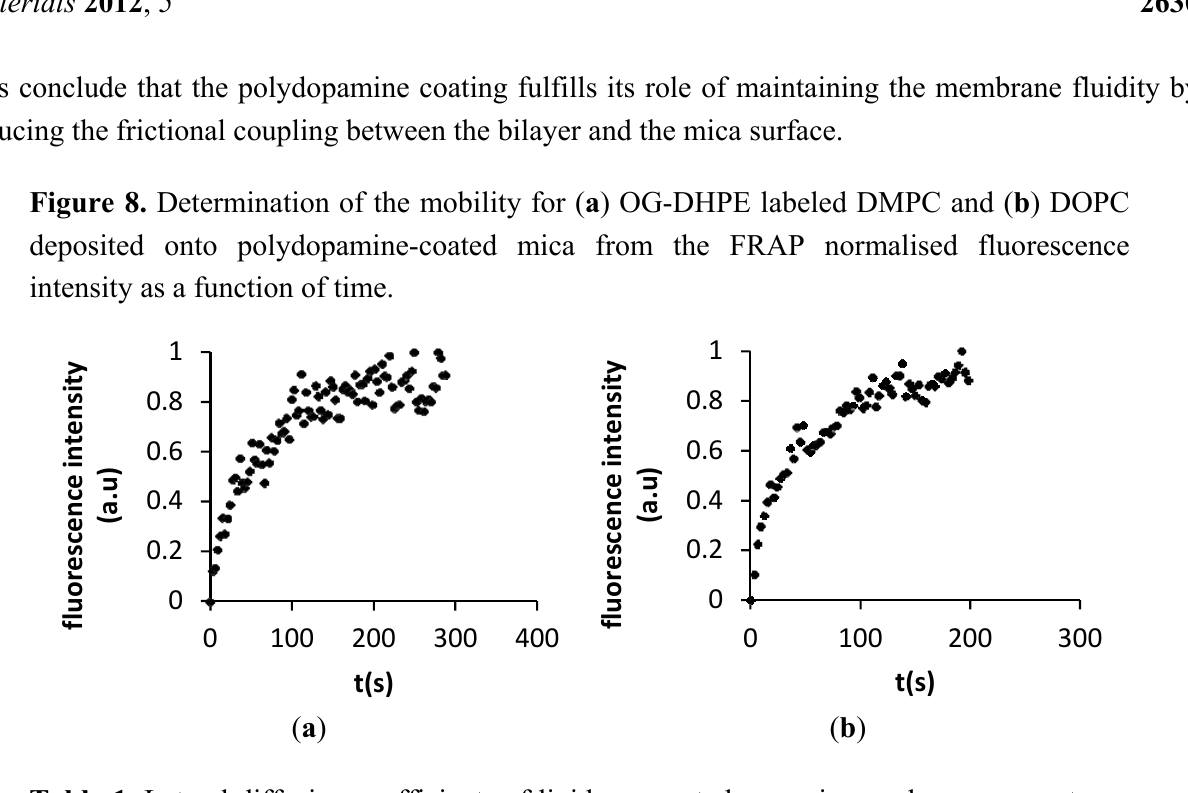
Table 1. Lateral diffusion coefficients of lipids supported on various polymer supports, as measured by fluorescence recovery after photobleaching